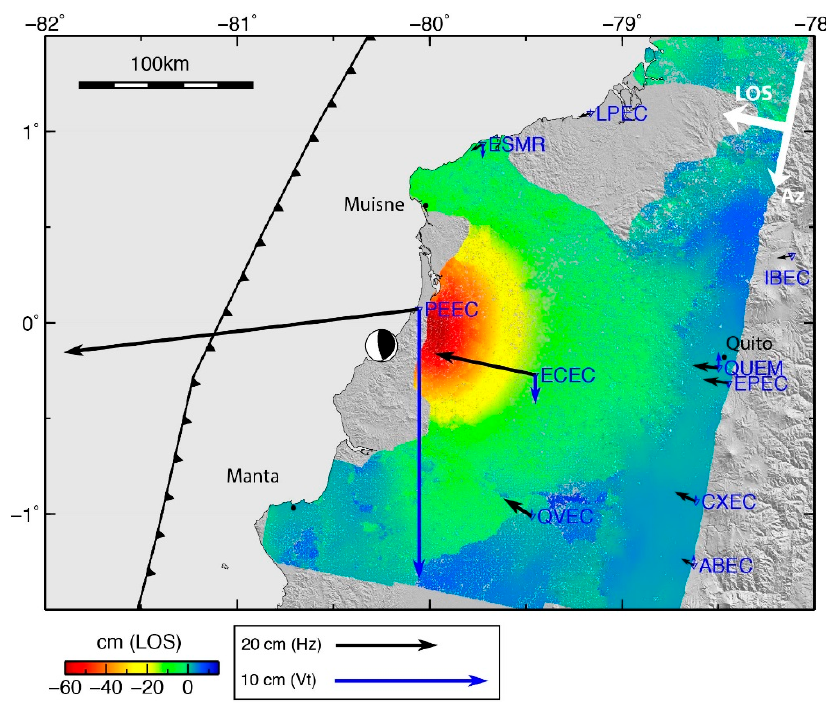
Figure 2. Coseismic displacement field from InSAR and GPS data. The coseismic interferogram (unwrapped) shows surface displacement in the line-of-sight direction. The white arrow indicates satellite Line-of-Sight direction (LOS) and satellite azimuth (Az). Black and blue arrows represent GNSS horizontal (black arrows) and vertical (blue arrows) displacements estimated from the Continuous Monitoring GNSS Network (REGME) in Ecuador, before and after the 16 April 2016, Mw7.8 Pedernales Earthquake. GNSS displacements and associated errors are shown in Table 1. Table 1. Coseismic displacements at the 17 cGPS sites used in this study.